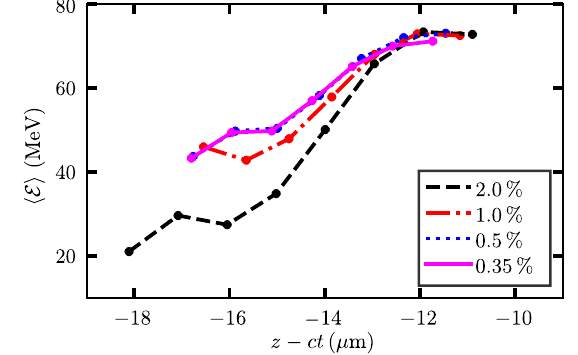
FIG. 5. Average energy h E i of electrons situated in the FWHM of the energy distribution of accelerated electrons at the early phase of acceleration, around z ¼ 2 . 7 mm.